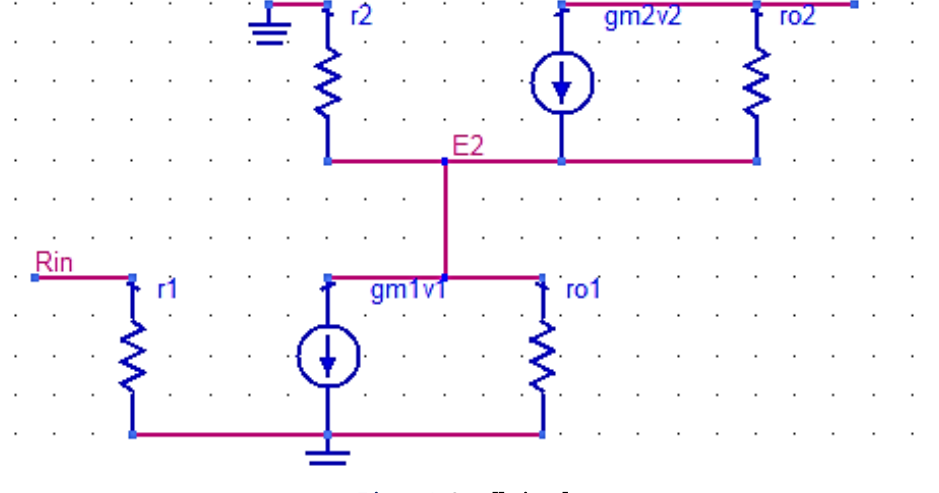
Figure 1. Small-signal.